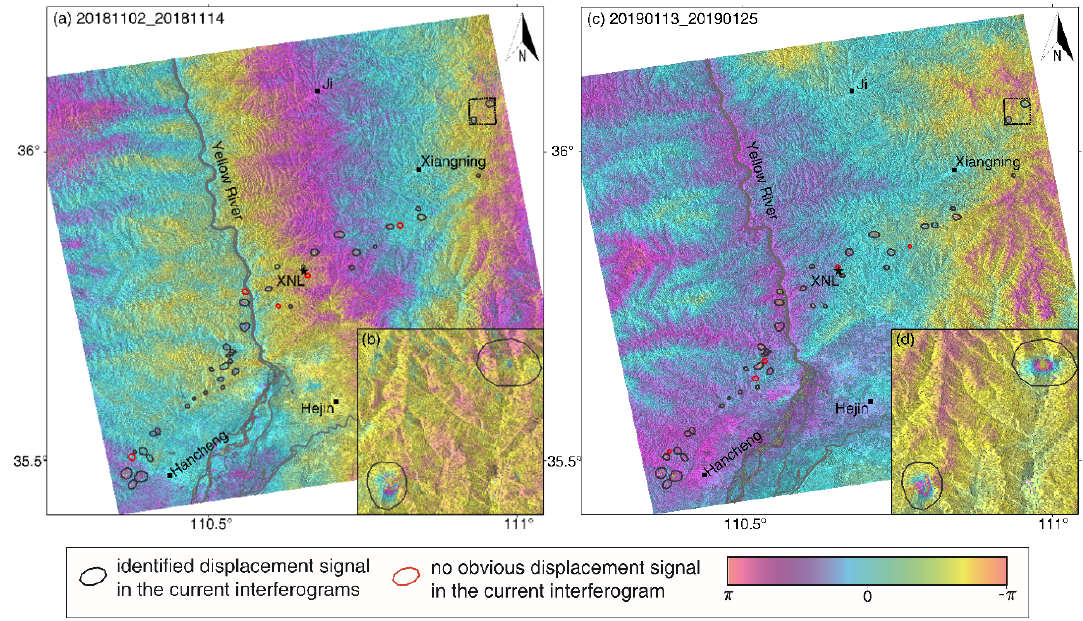
Figure 4. Differential interferograms produced from Sentinel-1 data pairs. ( a ) 20181102-20181114, ( c ) 20190113-20190125. ( b ) and ( d ) are enlarged interferograms marked with dashed rectangle in ( a ) and ( c ).